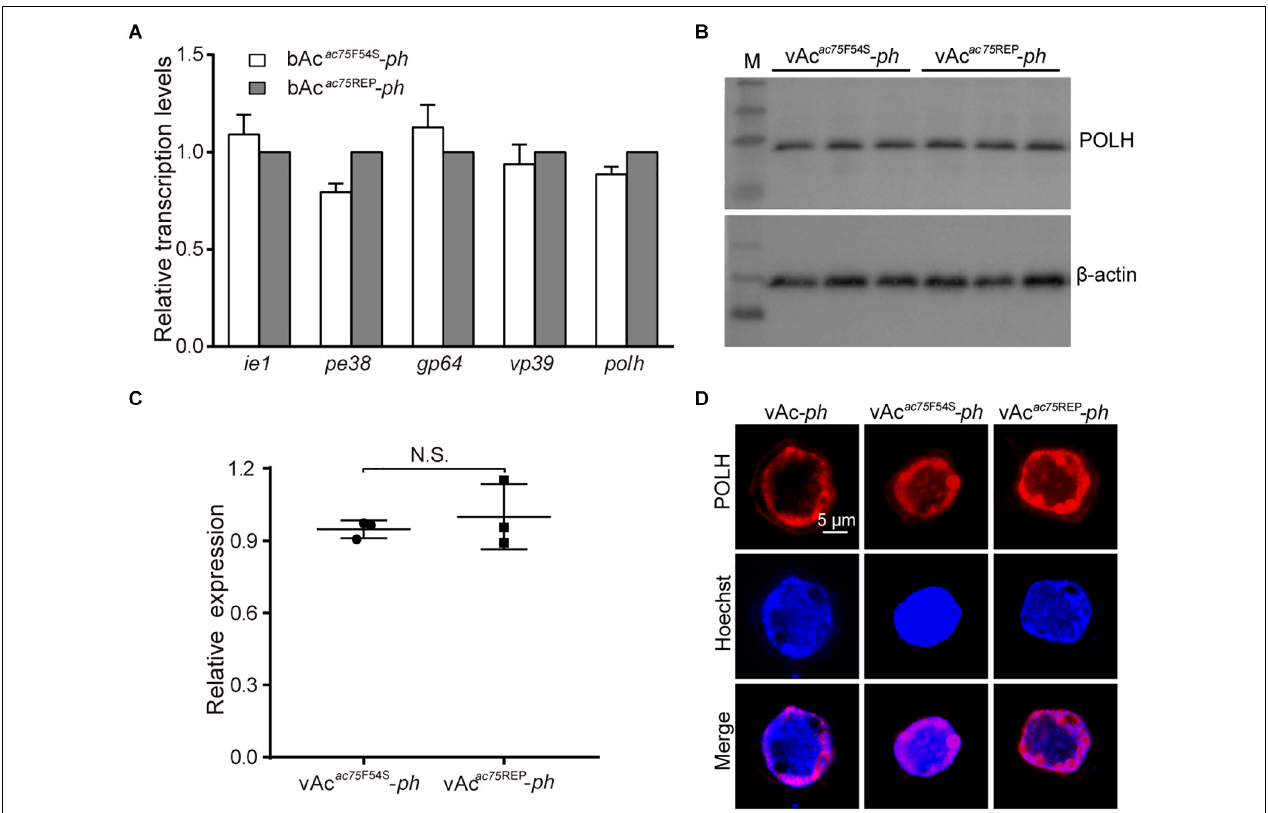
FIGURE 6 | Transcription, expression and localization analyses of polyhedrin . (A) RT-qPCR analysis. Total RNA was extracted from Sf9 cells transfected with either bAc ac 75 F 54 S - ph or bAc ac 75REP - ph at 24 h p.t. Transcription of selected viral genes was measured by RT-qPCR. The transcript level of each gene was normalized by 18S rRNA of the same sample. The values represent the averages from three independent assays and error bars represent SD. (B) Western blot analysis. Sf9 cells infected with vAc ac 75 F 54 S - ph or vAc ac 75REP - ph at an MOI of five were collected and lysed at 24 h p.i. The lysates were subjected to western blot analysis using anti-POLH and anti-actin (control) as primary antibodies. (C) Relative quantification of the expression levels of POLH by densitometry analysis of western blot. Each dot represents the expression level in one independent experiment relative to the mean for POLH in vAc- ph -infected cells at 24 h p.i. The values represent the averages from three independent assays and error bars represent SD. N.S. indicates no significance, P > 0.05. (D) Immunofluorescence analysis. Sf9 cells infected with vAc- ph , vAc ac 75 F 54 S - ph or vAc ac 75REP - ph at an MOI of 5 were fixed at 24 h p.i. and stained. The POLH are in red and nuclei are stained